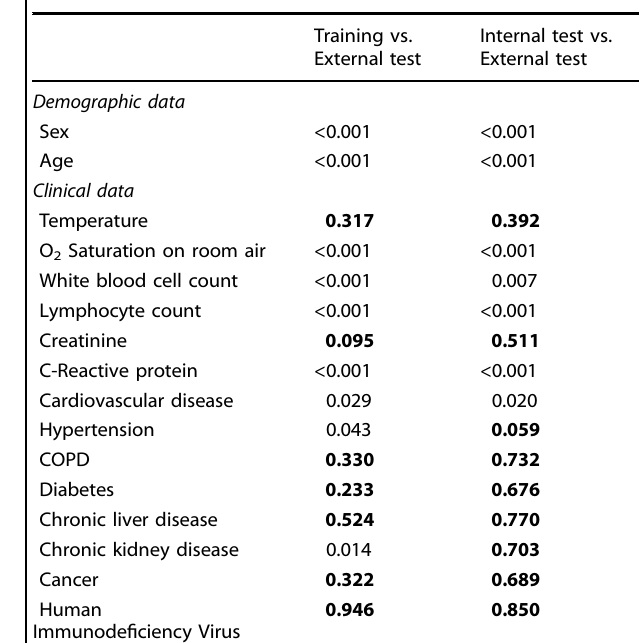
Table 1. Demographic variance across diagnosis model test datasets. Table 2. Demographic and clinical variance across prognosis model test